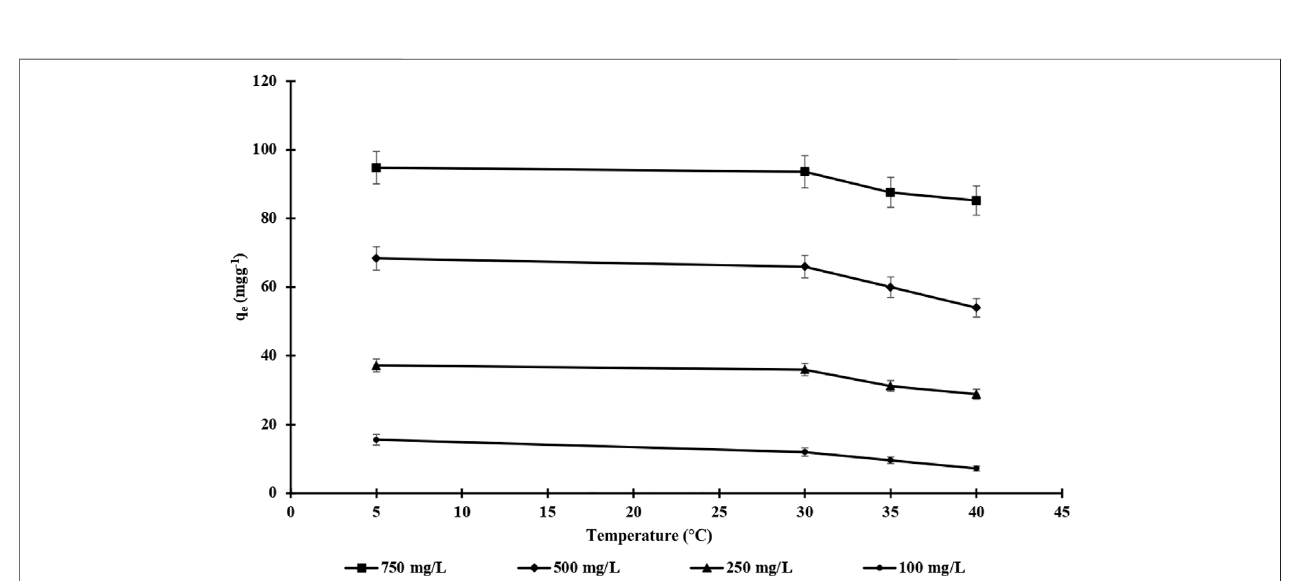
FIGURE 8 | The effect of endosulfan concentration and temperature on adsorption Capacity of m-DE-APTES.